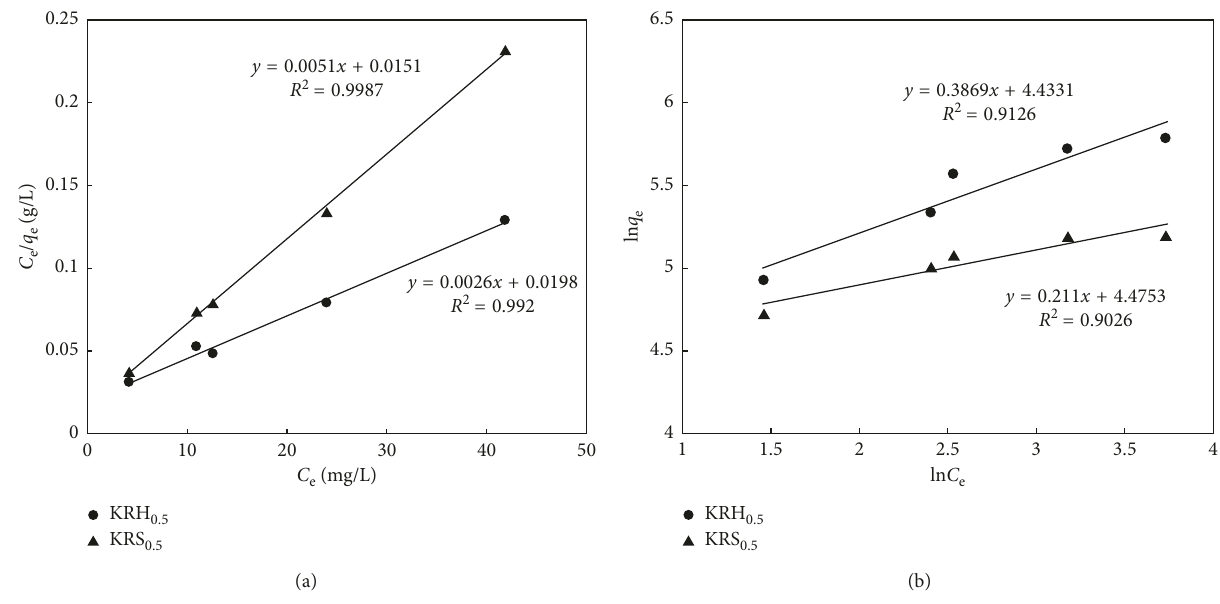
Figure 5: (a) Langmuir isotherms of KRH 0.5 on MG. (b) Freundlich isotherms of KRS 0.5 on